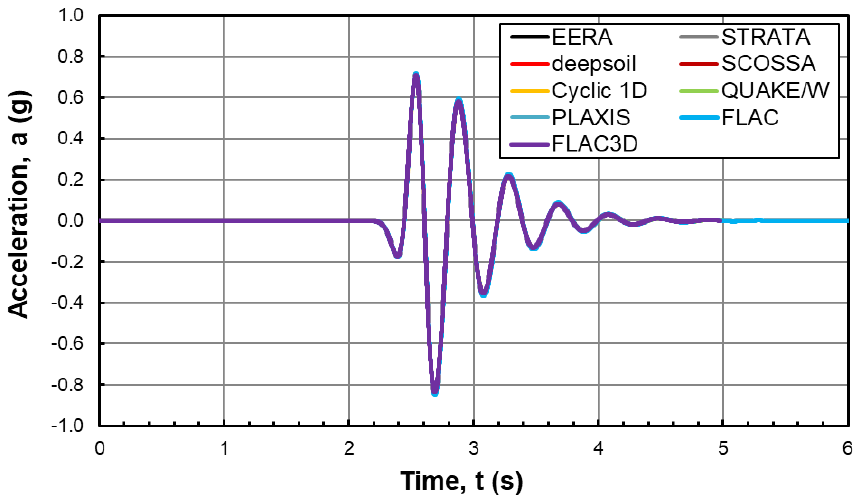
Figure 6. Temporal histories of the acceleration predicted at the surface of the soil column from the analyzes carried out with the nine considered